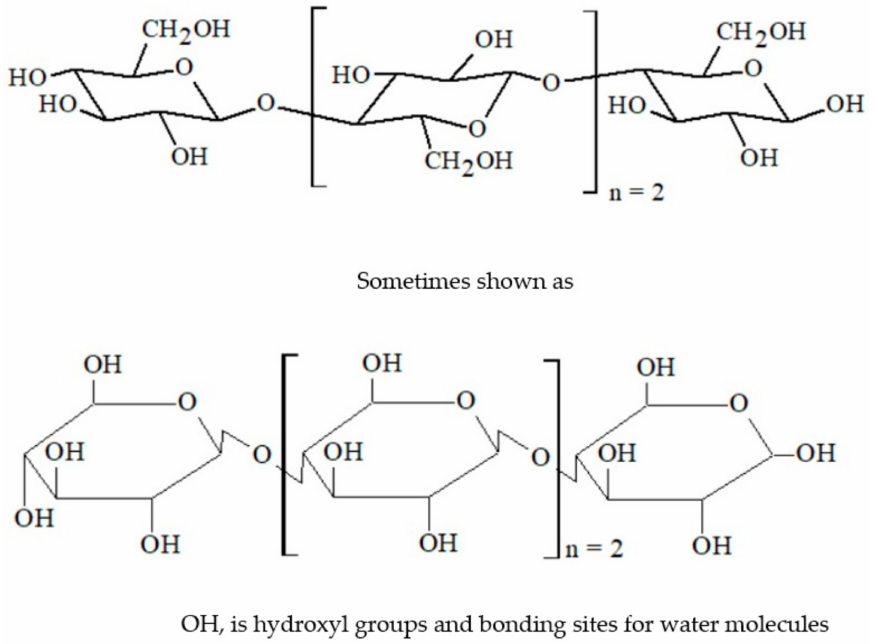
Figure 2. Cellulose structure in the cell walls of wood